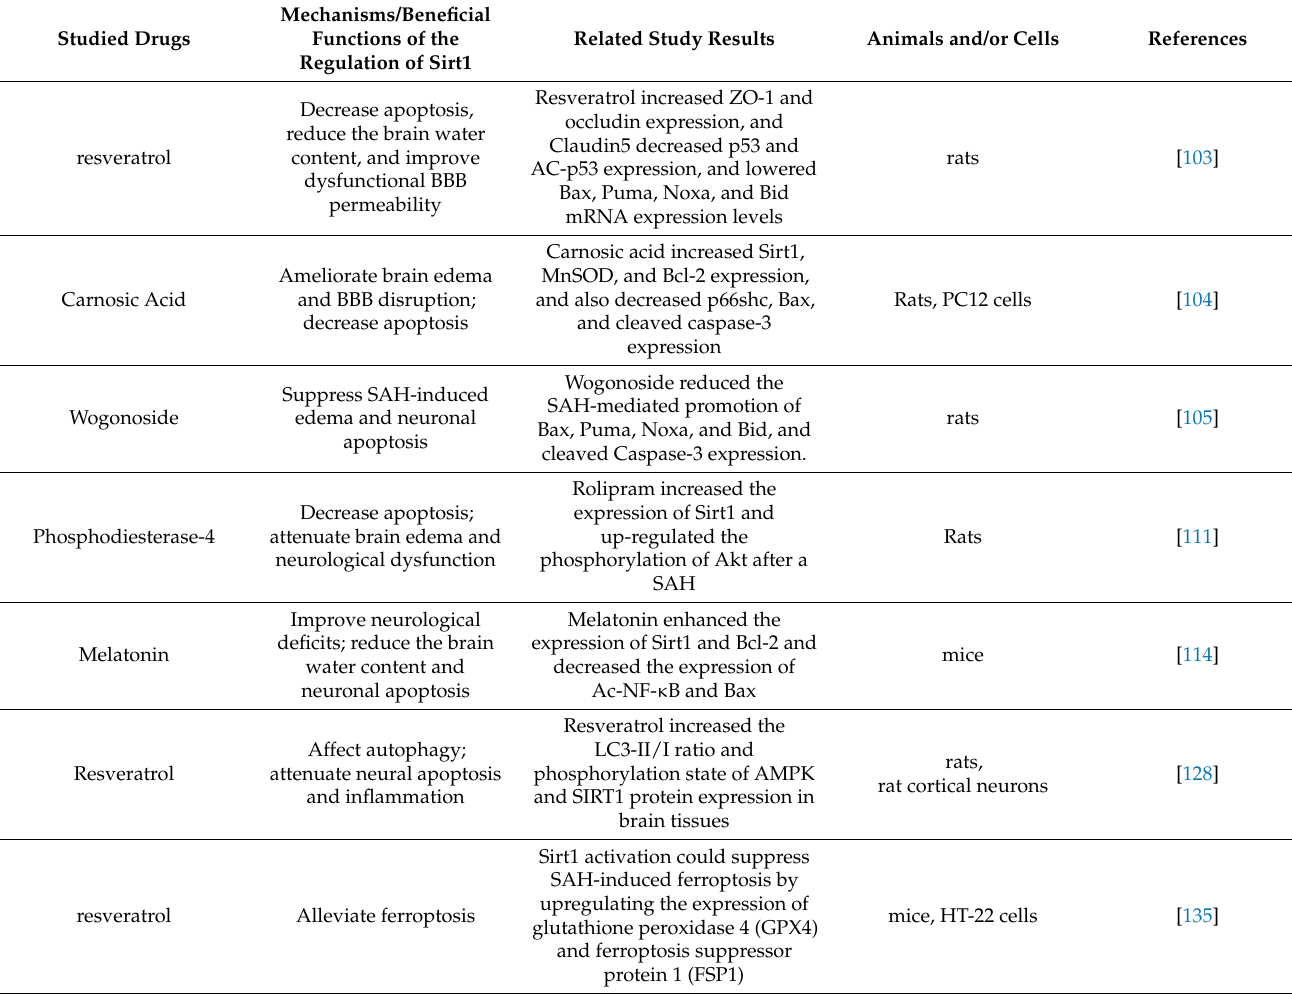
Table 3. Related studies exploring Sirt1-targeted PCD therapy for